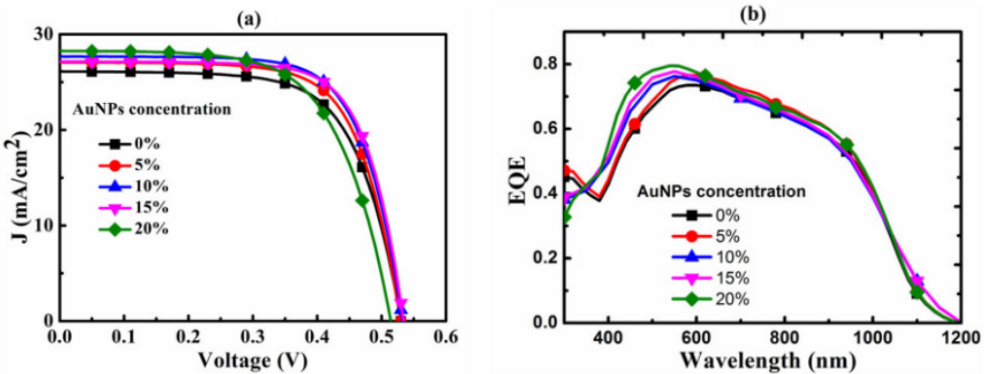
Figure 32. ( a ) The J - V characteristics of c-Si/PEDOT:PSS(AuNPs) heterojunction devices under AM 1.5G 100mWcm − 2 white-light illumination. ( b ) External quantum efficiency (EQE) versus wavelength for corresponding heterojunction cells. (Reproduced with permission from [155], Copyright John Wiley and Sons